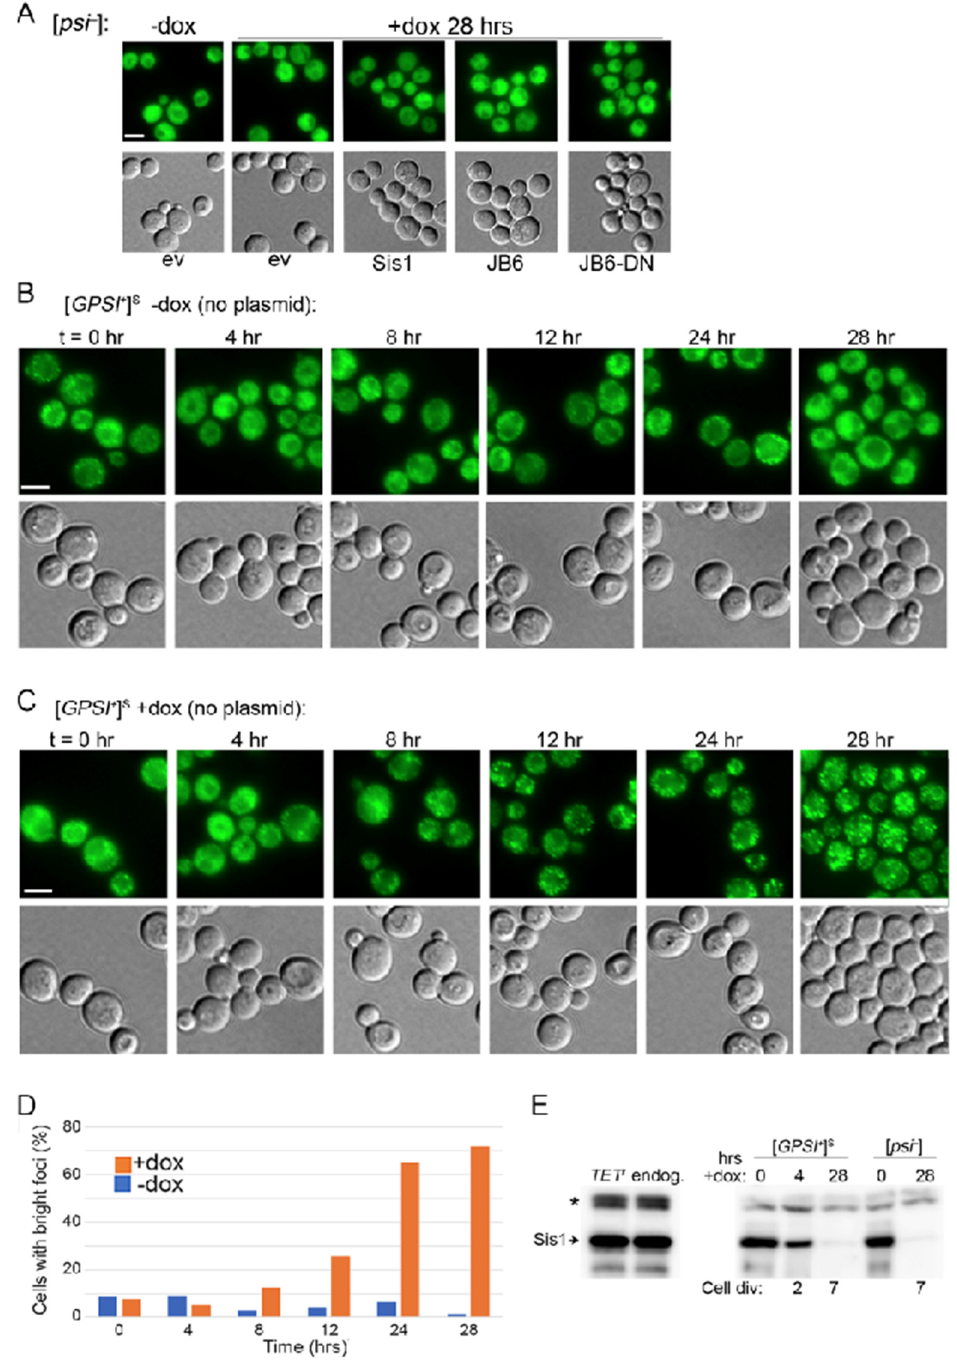
Figure 3. Depleting Sis1 causes hyper-aggregation of NGMC in [ PSI + ] cells of strain 2140. ( A ) NGMC fluorescence is diffuse in the cytoplasm of [ psi − ] cells with or without doxycycline, or with plasmids that express the test proteins or carry empty vector (ev) indicated below. ( B ) NGMC fluorescence over time for [G PSI + ] S cultures without doxycycline. ( C ) Same as in panel ( B ) but doxycycline was added at time t = 0. ( D ) Quantitation of percent of cells in population in panel ( B ) that have large bright aggregates; ( n = 100–200). ( E ) Western blot probing for Sis1 expressed from TETr or endogenous promoter ( left , asterisk indicates cross-reacting bands useful as load control); and in [ PSI + ] S and [ psi − ] cells exposed to doxycycline for indicated times ( right ). Numbers below indicate number of cell divisions. Scale bars = 5 µ m; all images in each panel are at same scale.